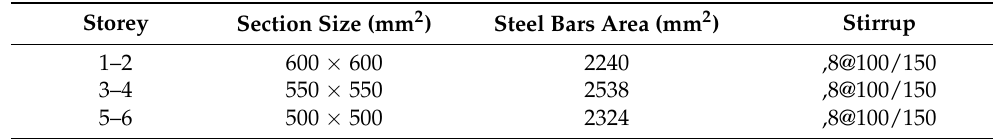
Table 1. Sizes and reinforcement details of frame